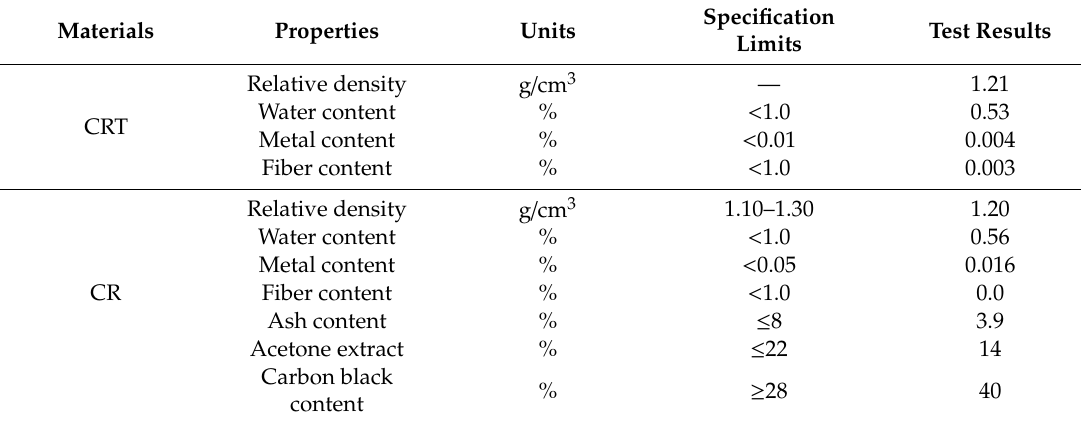
Table 4. Performance of CRT and crumb rubber